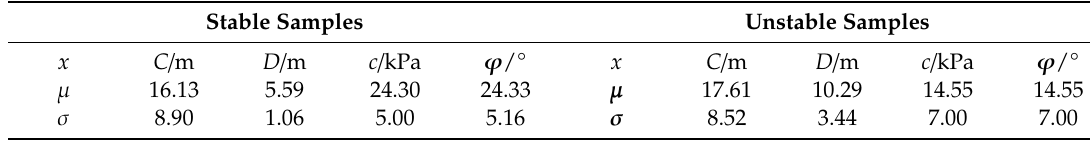
Table 3. Parameters associated with PDF (the second classifier).